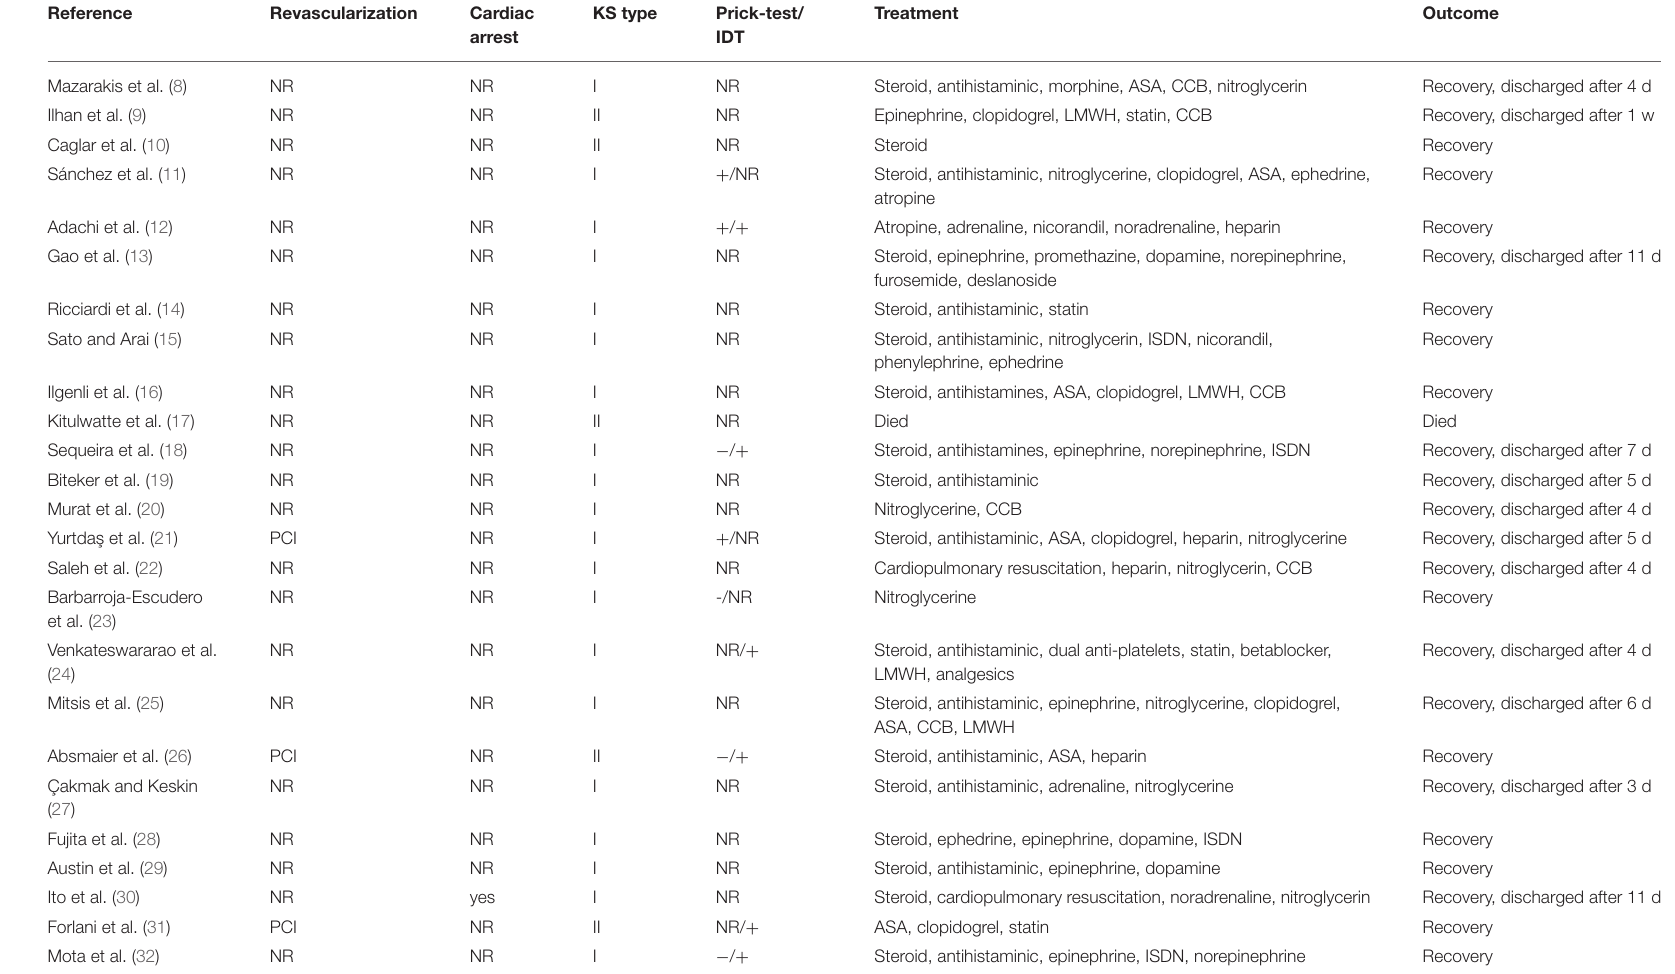
TABLE 3 | Treatment and outcome of the 25 included